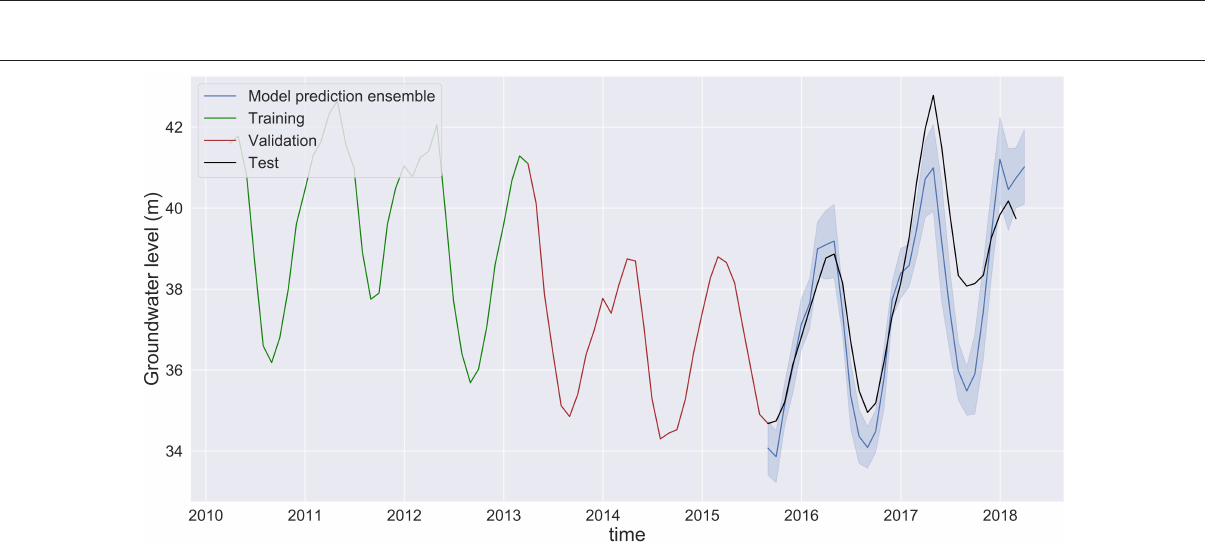
FIGURE 8 | Groundwater level prediction at Butte using monthly averaged data for all features (groundwater, temperature, precipitation, and river flow). Although the ensemble spread is narrow (the model predictions are reliable), the prediction error is high, indicating a lack of sufficiently numerous training data